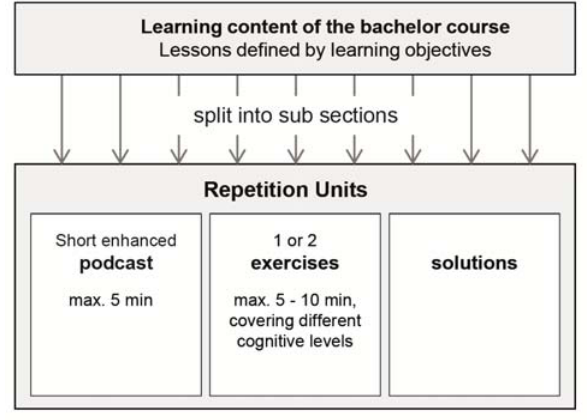
Figure 1. Conceptual design of the Repetition Units (a)